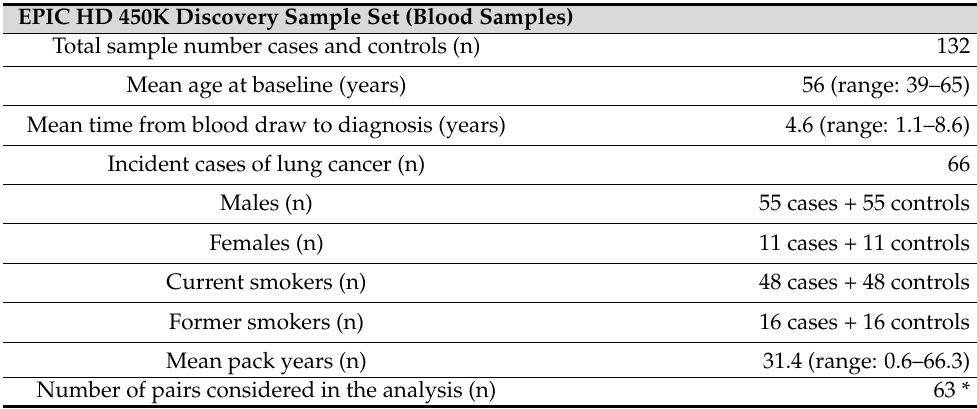
Table 1. Characteristics of the EPIC HD discovery blood sample